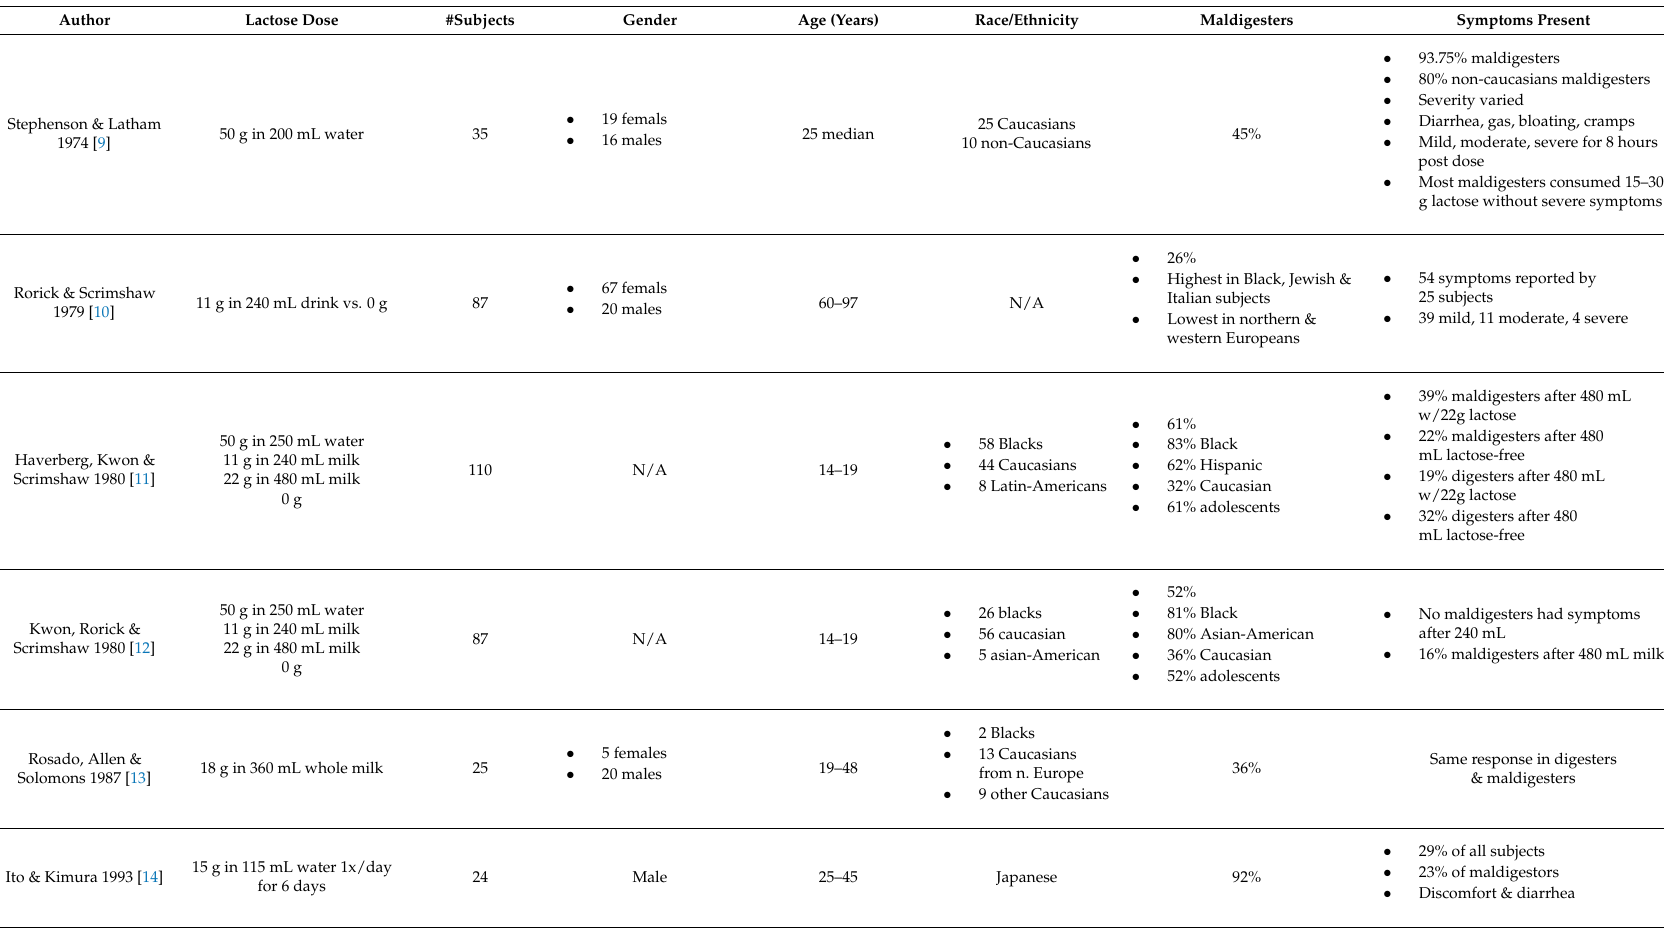
Table 1. Publications reporting on lactose dose, gender, age, race/ethnicity and